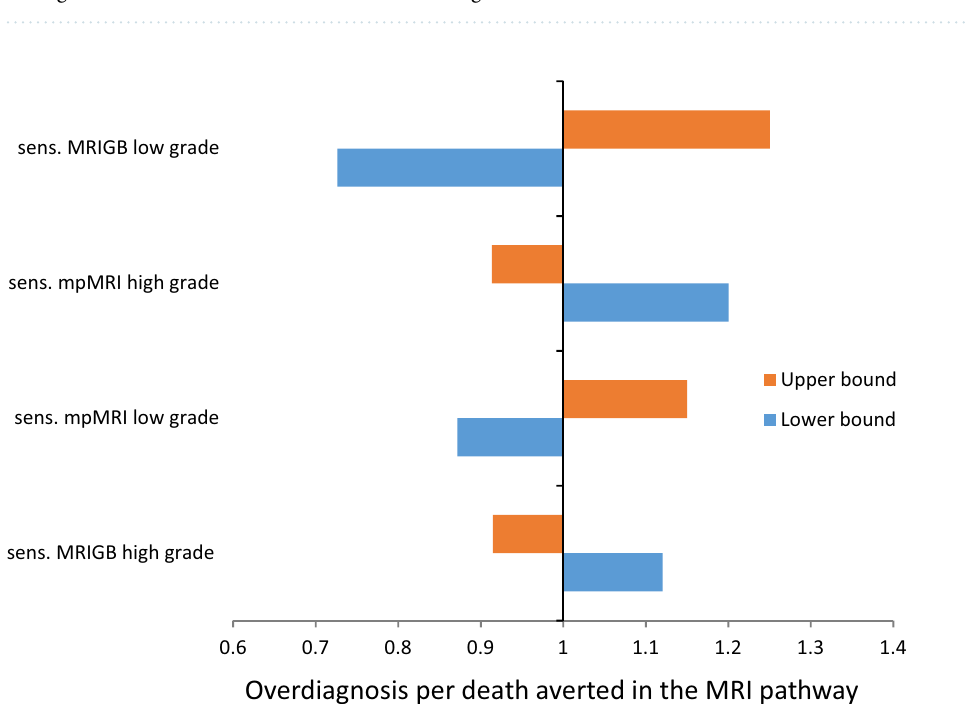
Table 2. Predictions of the effects of prostate cancer screening for men between age 55–64 at 3 years intervals using regular pathway and MRI pathway, per 1000 men. a Clinically insignificant cancer was defined as Gleason score 6 and below (it contains both screen detected and interval cancer). b Clinically significant prostate cancer was defined as Gleason score 7 or more (it contains both screen detected and interval cancer). c Overdiagnosed cancer was defined as a prostate cancer detected during screening but would not have been clinically diagnosed during the man’s life time in the absence of screening.